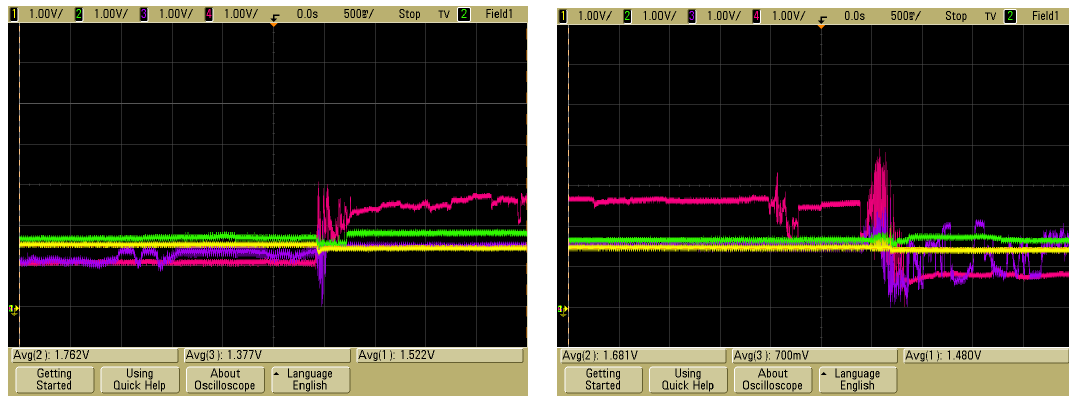
Figure 21. Application of the